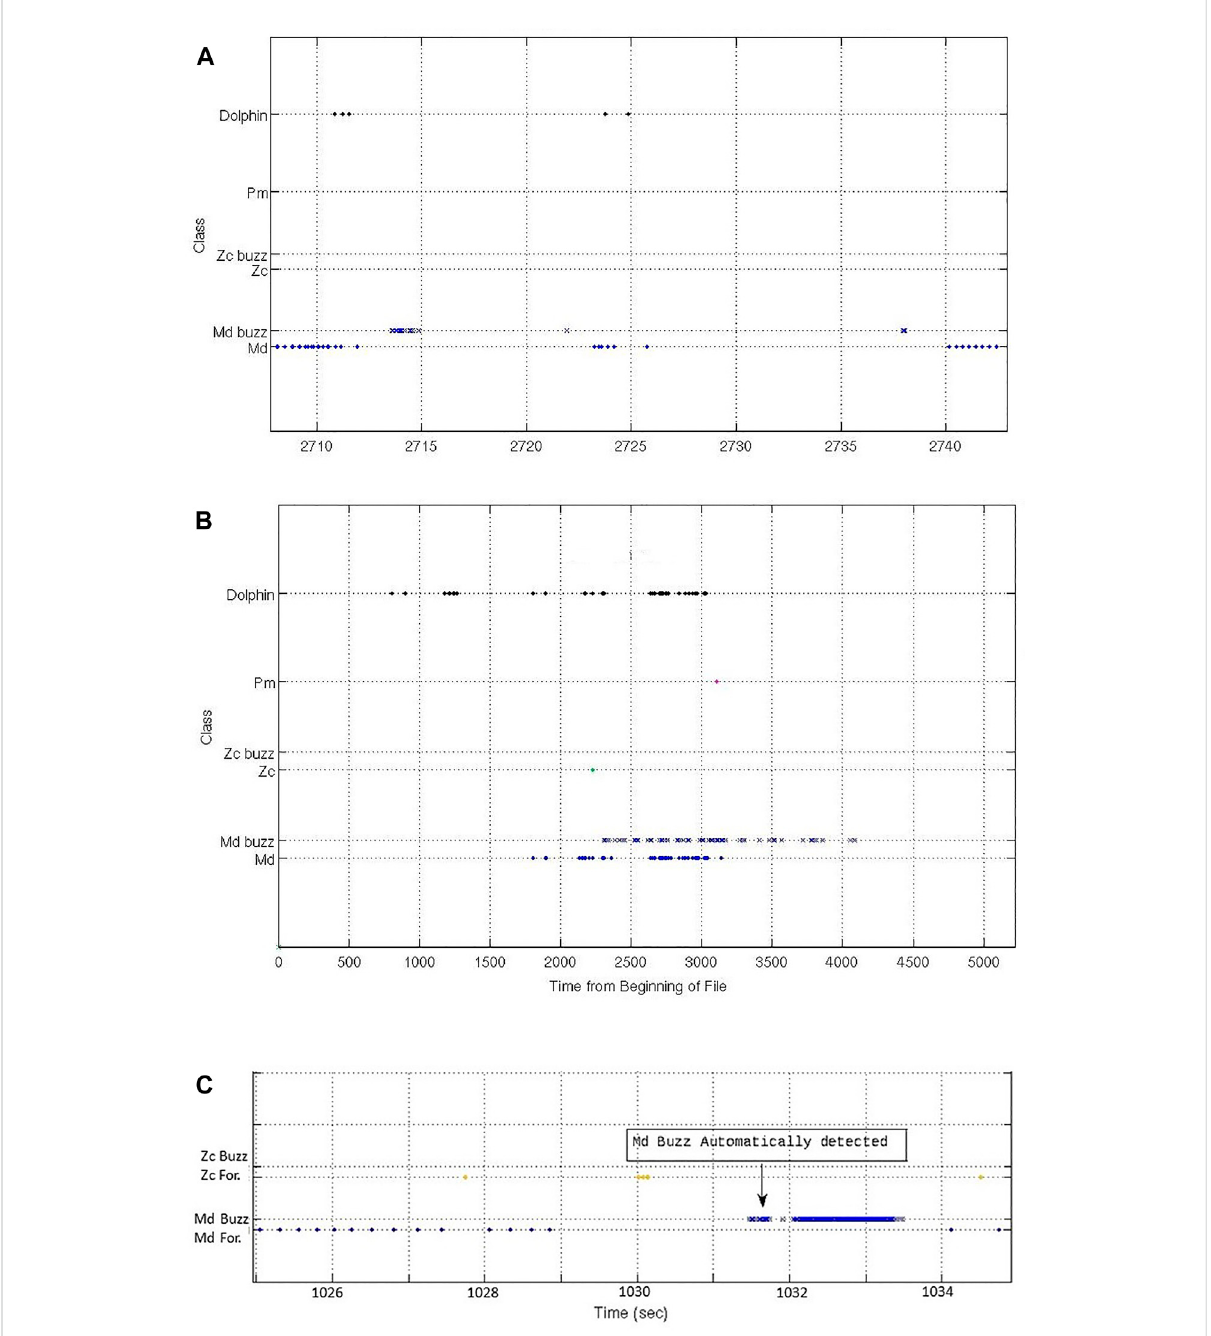
FIGURE 4 (A) Output of AUTEC CS-SVM classi fi er from hydrophone 56 showing rhythmic Md foraging clicks (blue dots) and then two buzz detections (blue x ’ s). Black dots are false positives from the generalized dolphin class. (B) Output of AUTEC CS-SVM classi fi er from hydrophone 56 from a different hour during the study. Again, blue dots are Md foraging clicks, black dots are generalized dolphin clicks and blue x ’ s are buzz click detections. Notice that buzz detections continue after Md foraging click detections. These are most likely false positives caused by dolphin clicks.Inthiscase,CTP,AGandBTPruleswerenotmetandnobuzzeswereidenti fi ed. (C) Aclose-upof Md foragingclicks(bluedots)transitioningto a long buzz detection (blue x ’